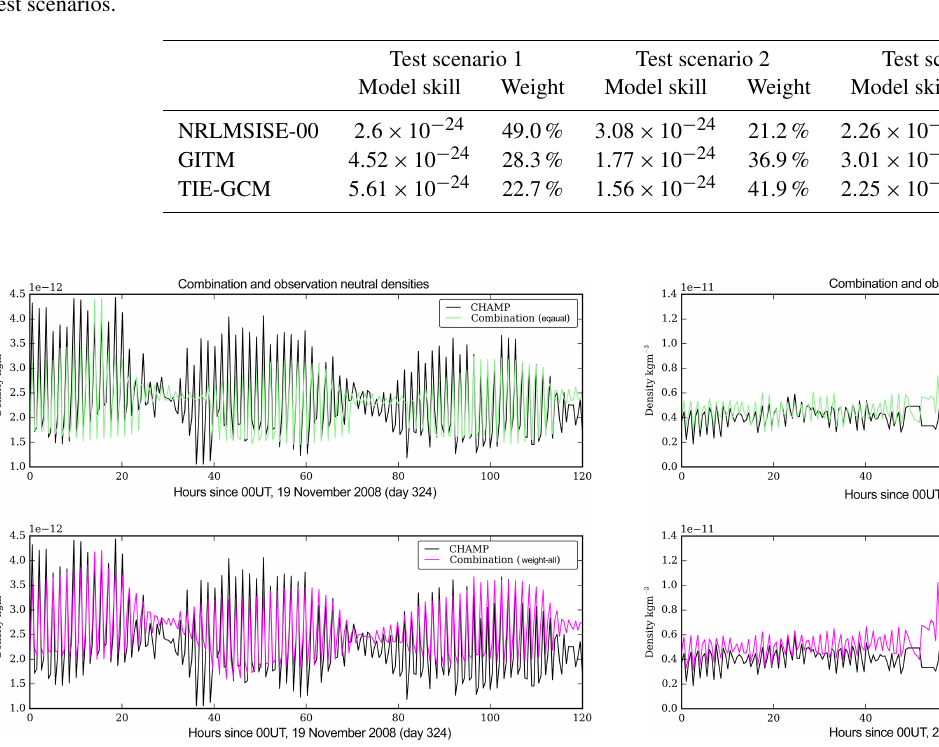
Figure 8. Neutral density values of the two MMEs for the second test scenario, equally weighted and all-times weighted.